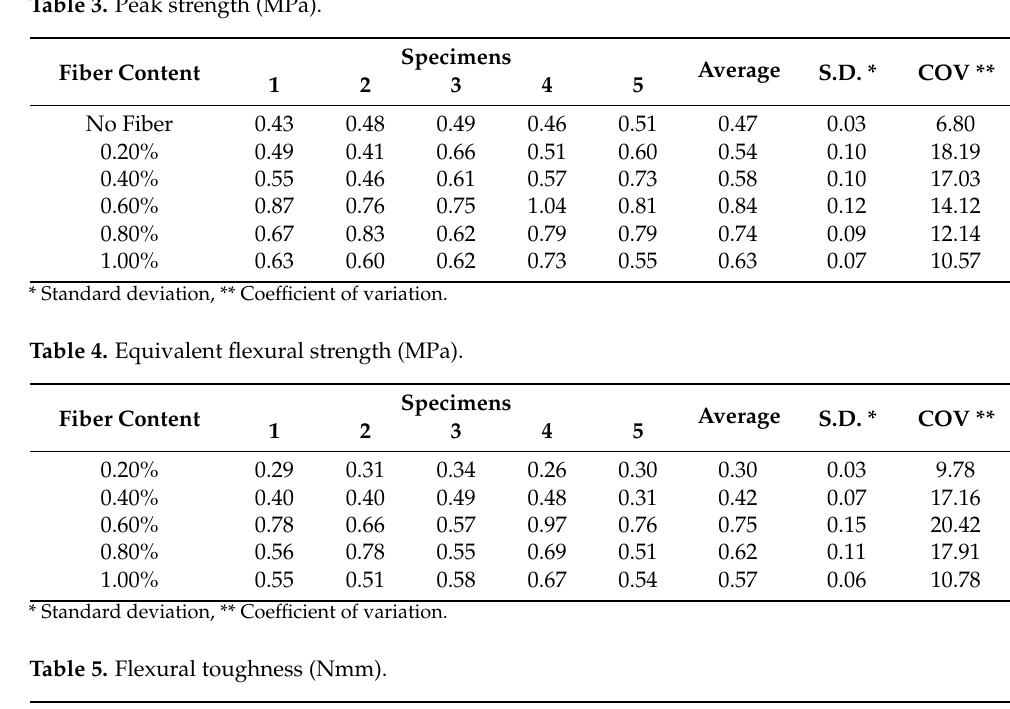
Table 3. Peak strength (MPa).